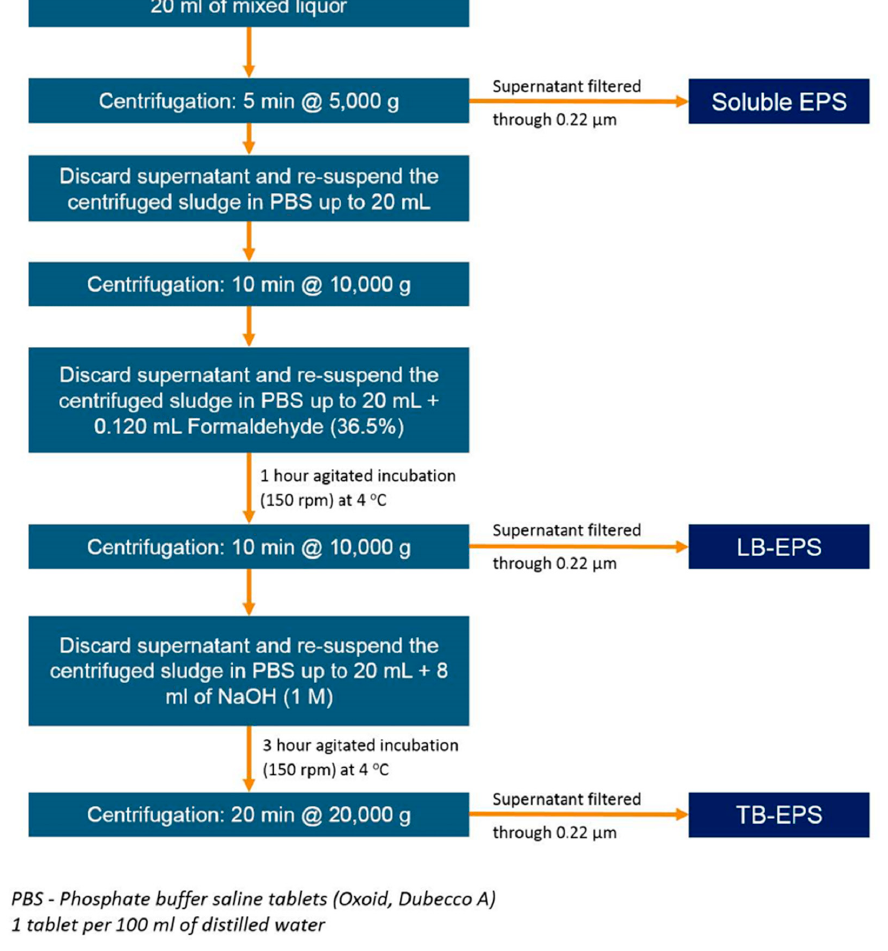
Figure A1. Flowchart for EPS extraction procedure.